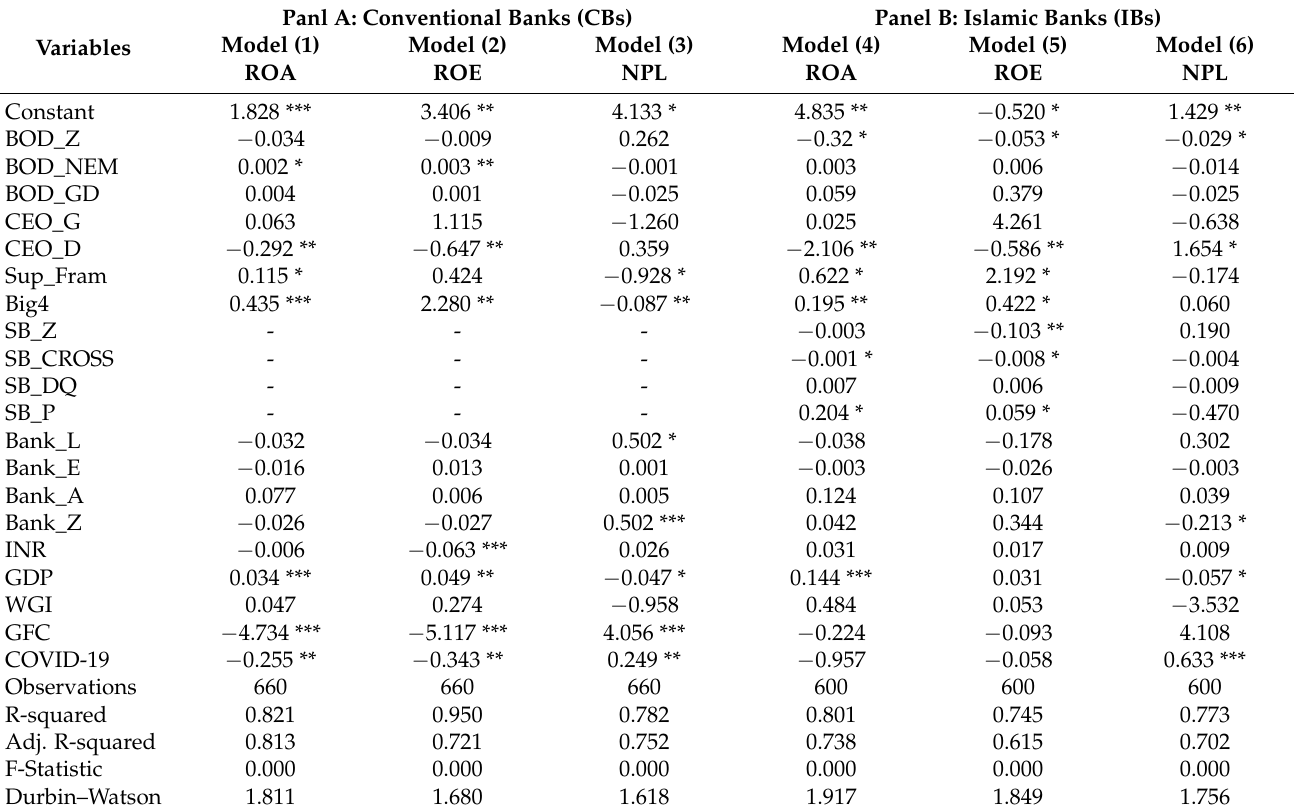
Table 5. Multi-layer corporate governance and bank performance—Full period